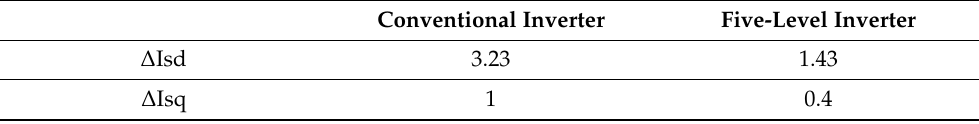
Figure 12. FFT analysis of the Isd and the fundamental harmonic THD: ( a ) conventional inverter; ( b ) five-level inverter. Table 3. Δ Isd and Δ Isd of two- and five-level inverters.